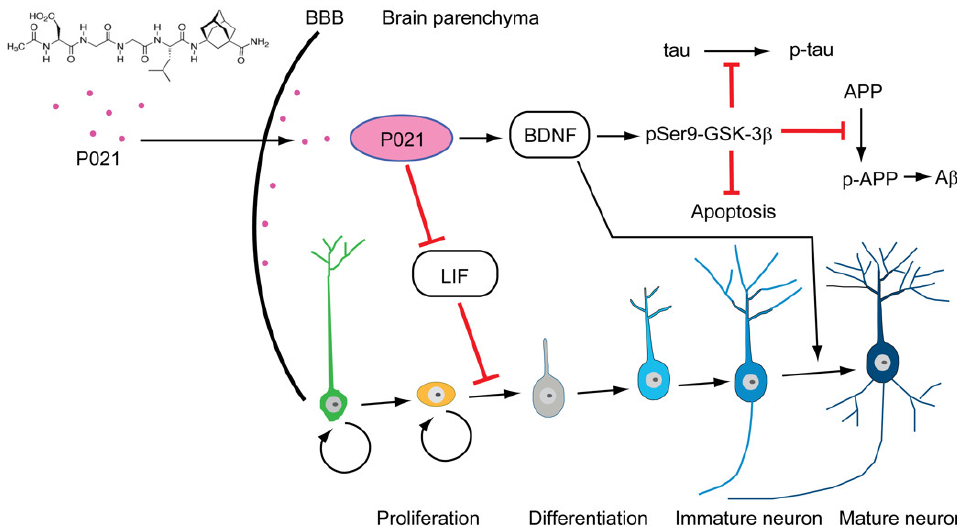
Figure 3. Mechanism of action of P021. P021 acts by competitively inhibiting leukemia inhibitory factor (LIF) signaling and increasing the expression level of BDNF. Together, the inhibition of LIF signaling and the increase in BDNF expression would inhibit stem cell proliferation and promote their development. BDNF has been shown to increase synaptic plasticity, neurogenesis, and cell survival. An increase in BDNF expression leads to an increase in the inhibitory phosphorylation of GSK3 β at Serine 9. The prevention of A β and tau pathologies with P021 could be through the inhibition of GSK3 β signaling. The inactivation of GSK3 β would result in a reduction of the A β load and tau hyperphosphorylation. GSK3 β is further known to promote apoptosis, and its inhibition would also lead to the inhibition of neurodegeneration.